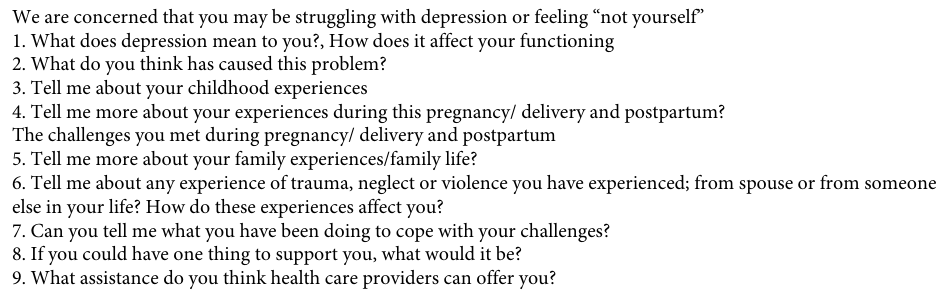
Table 1. A summary of interview guide for perinatal